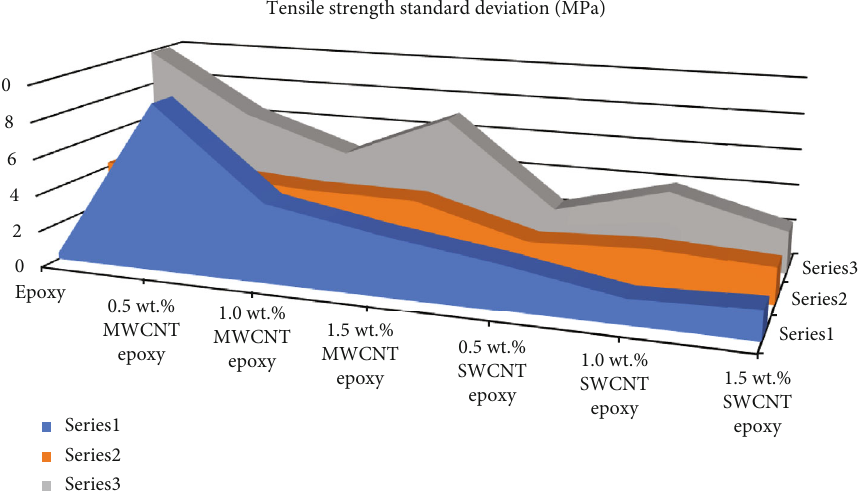
Figure 10: Tensile strength standard deviation obtained from all CNT-epoxy specimens.